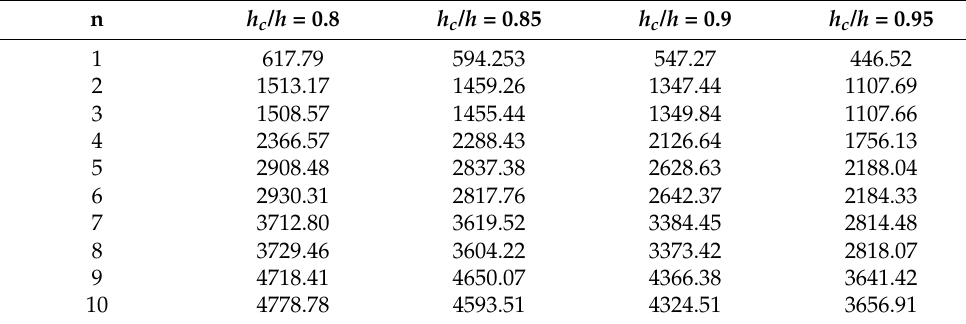
Table 3. Frequencies of ZPR honeycomb plate with core thickness ratio change.